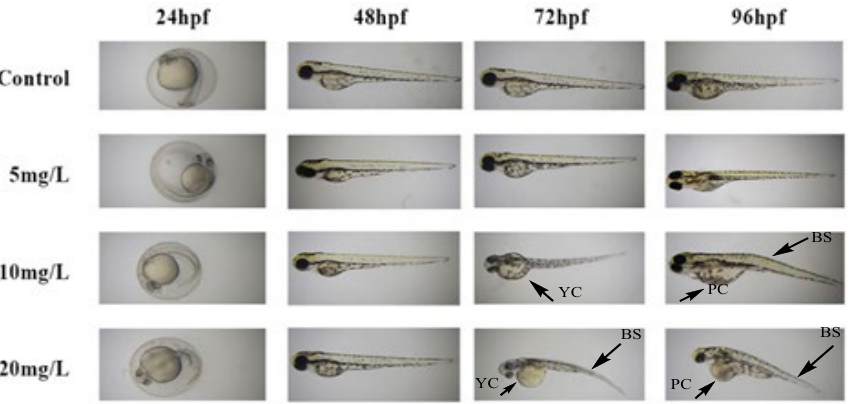
Figure 4. Zebrafish embryo malformation after exposure to compound 13p . Note: BS, bent spine; PC, pericardial cyst; YC, yolk cyst.